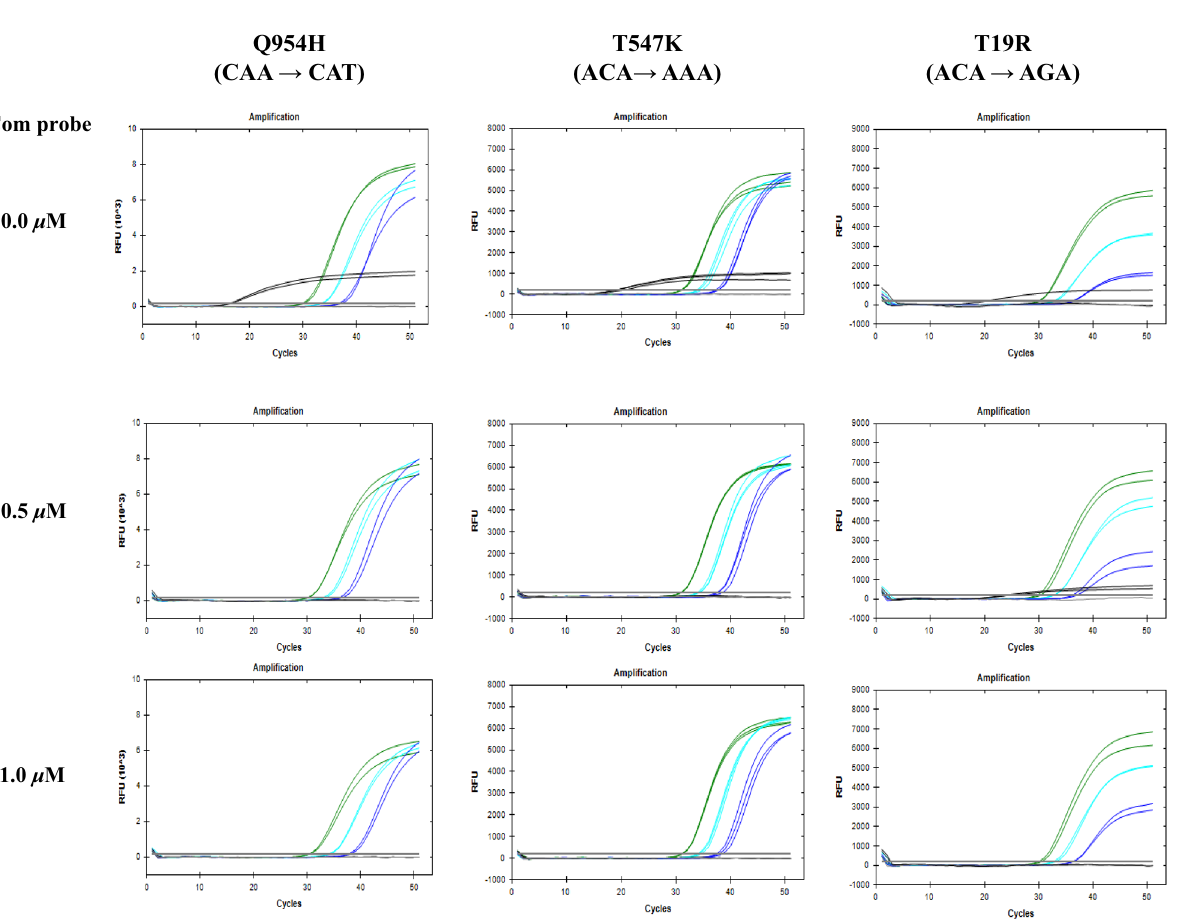
Figure 3. Diminish of nonspecific signals by utilizing Com probes. Multiplex probes consist of elongated probes 2 ~ 3 bases added from the original probe and Com probes. Each PCR trial is performed in